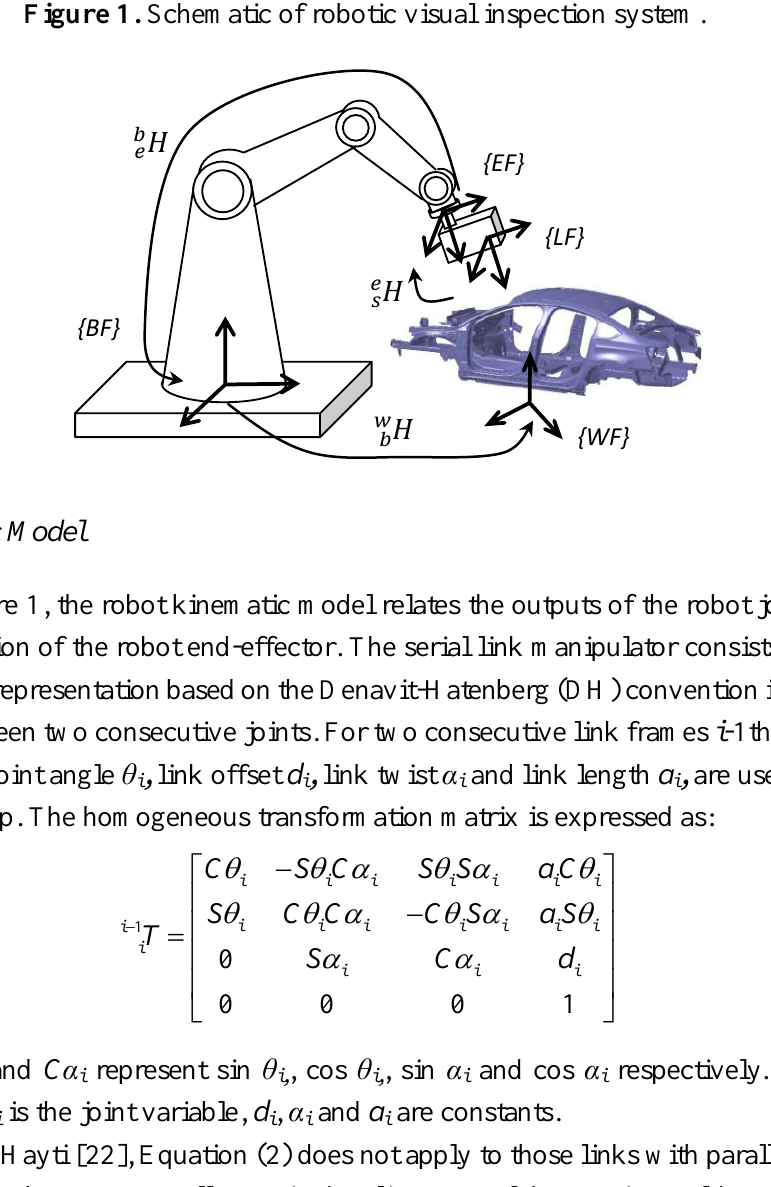
Figure 1. Schematic of robotic visual inspection